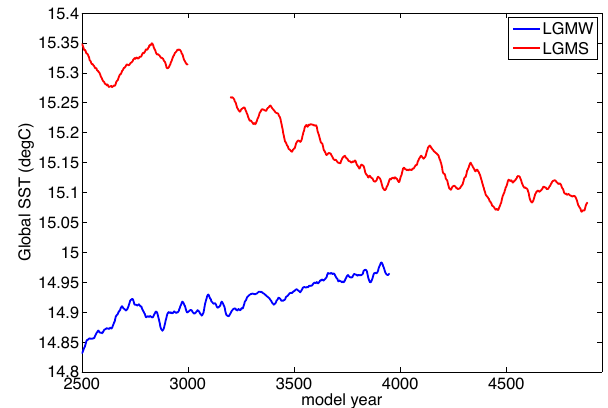
Fig. 3. 100yr running mean for global mean SST in LGMW (blue) Figure 3 100-year running mean for global mean SST in LGMW (blue) and and LGMS (red). The gap between the model year 3000–3200 in LGMS (red). The gap between the model year 3000-3200 in LGMS is due to LGMS is due to missed dataset. Units: ◦ missed dataset. Units: °C.